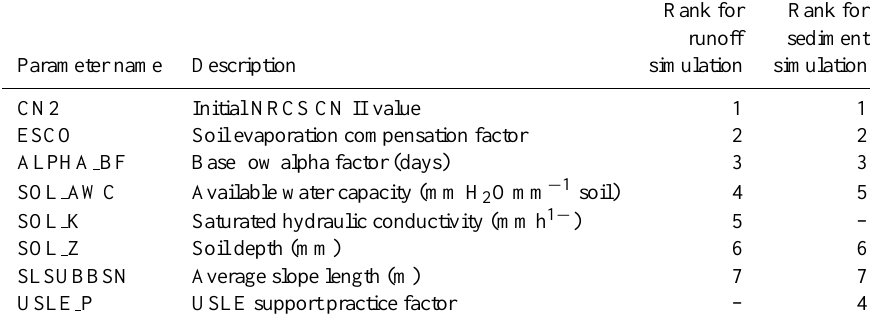
Table 1. Parameter sensitivity analysis